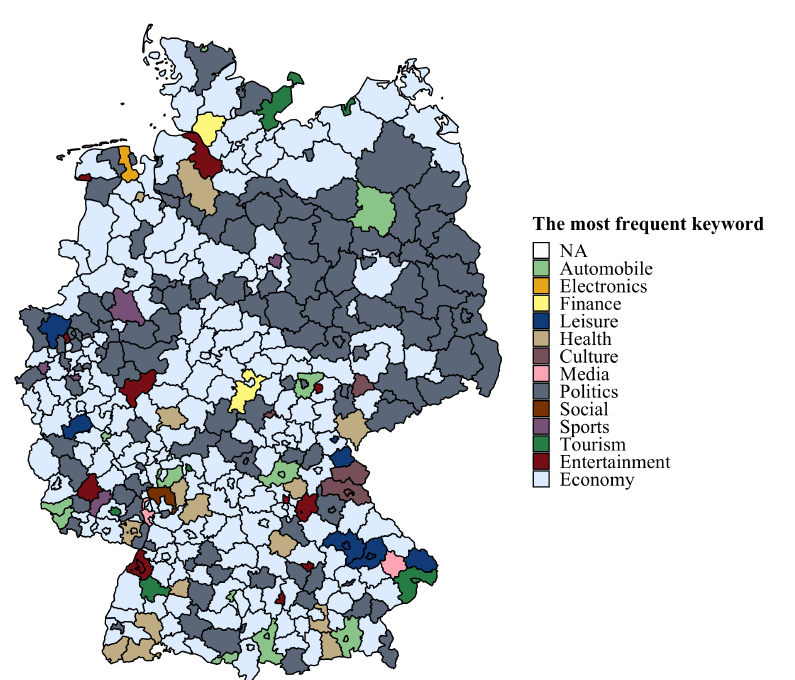
Figure 3: The most frequent keyword in each